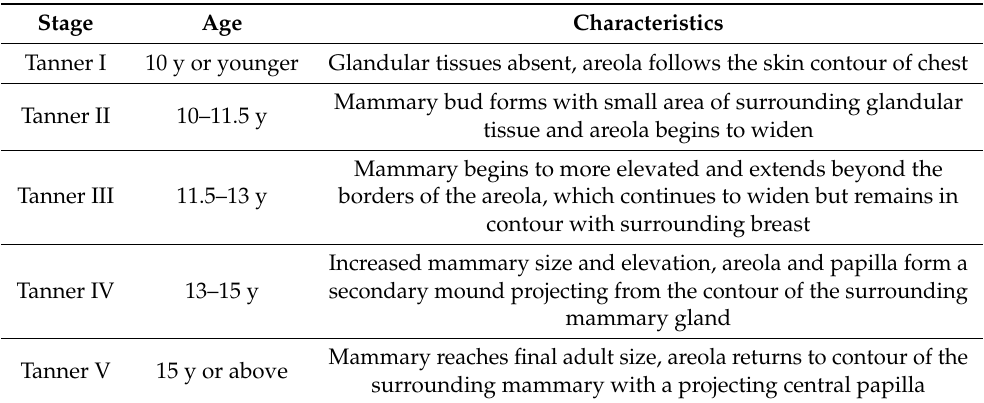
Table 2. Classification of human mammary gland development based on Tanner